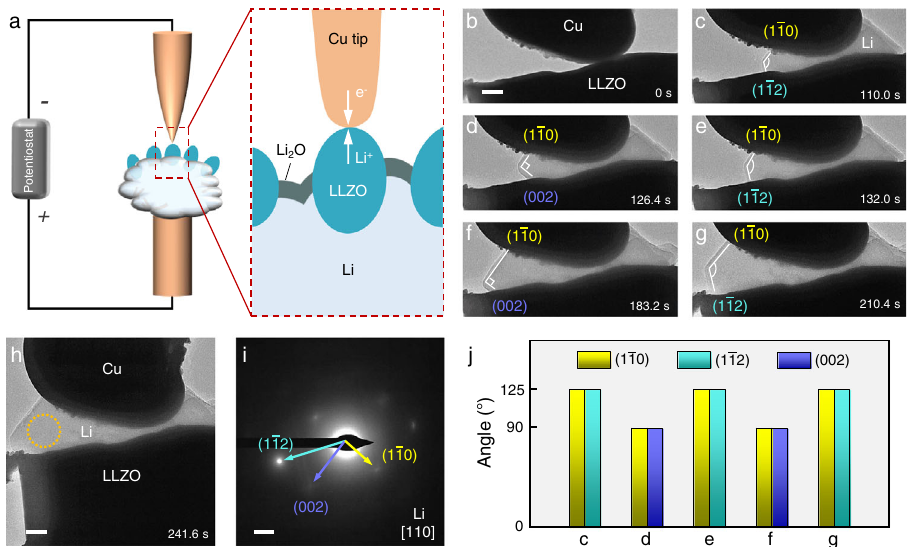
Fig. 1 | Morphological evolution of single-crystal Li metal growing at the Cu| LLZO interface. a Schematic of the anode-free Cu|LLZO|Li nanobattery setup for in situ TEM probing. b – h Time-lapsed TEM images revealing the Li growth on the LLZOsurfaceby creeping undera rigidconstraint from the Cu current collector at